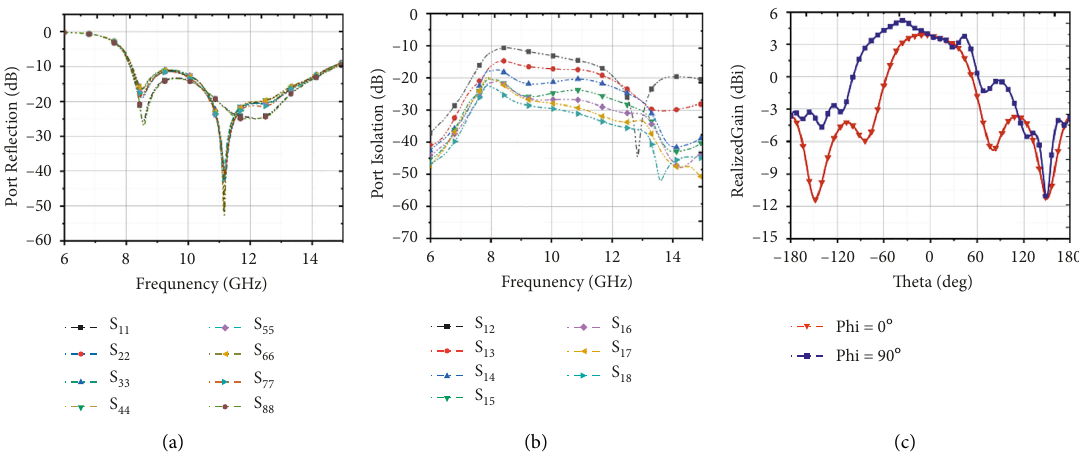
Figure 4: The performance of the phased array. (a) Port reflection coefficient curve of phased array. (b) Port isolation curve between antennas. (c) The pattern of the first antenna at